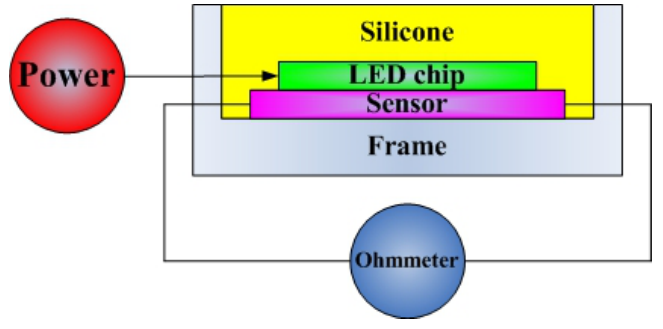
Figure 4. Illustration of micro temperature sensor in